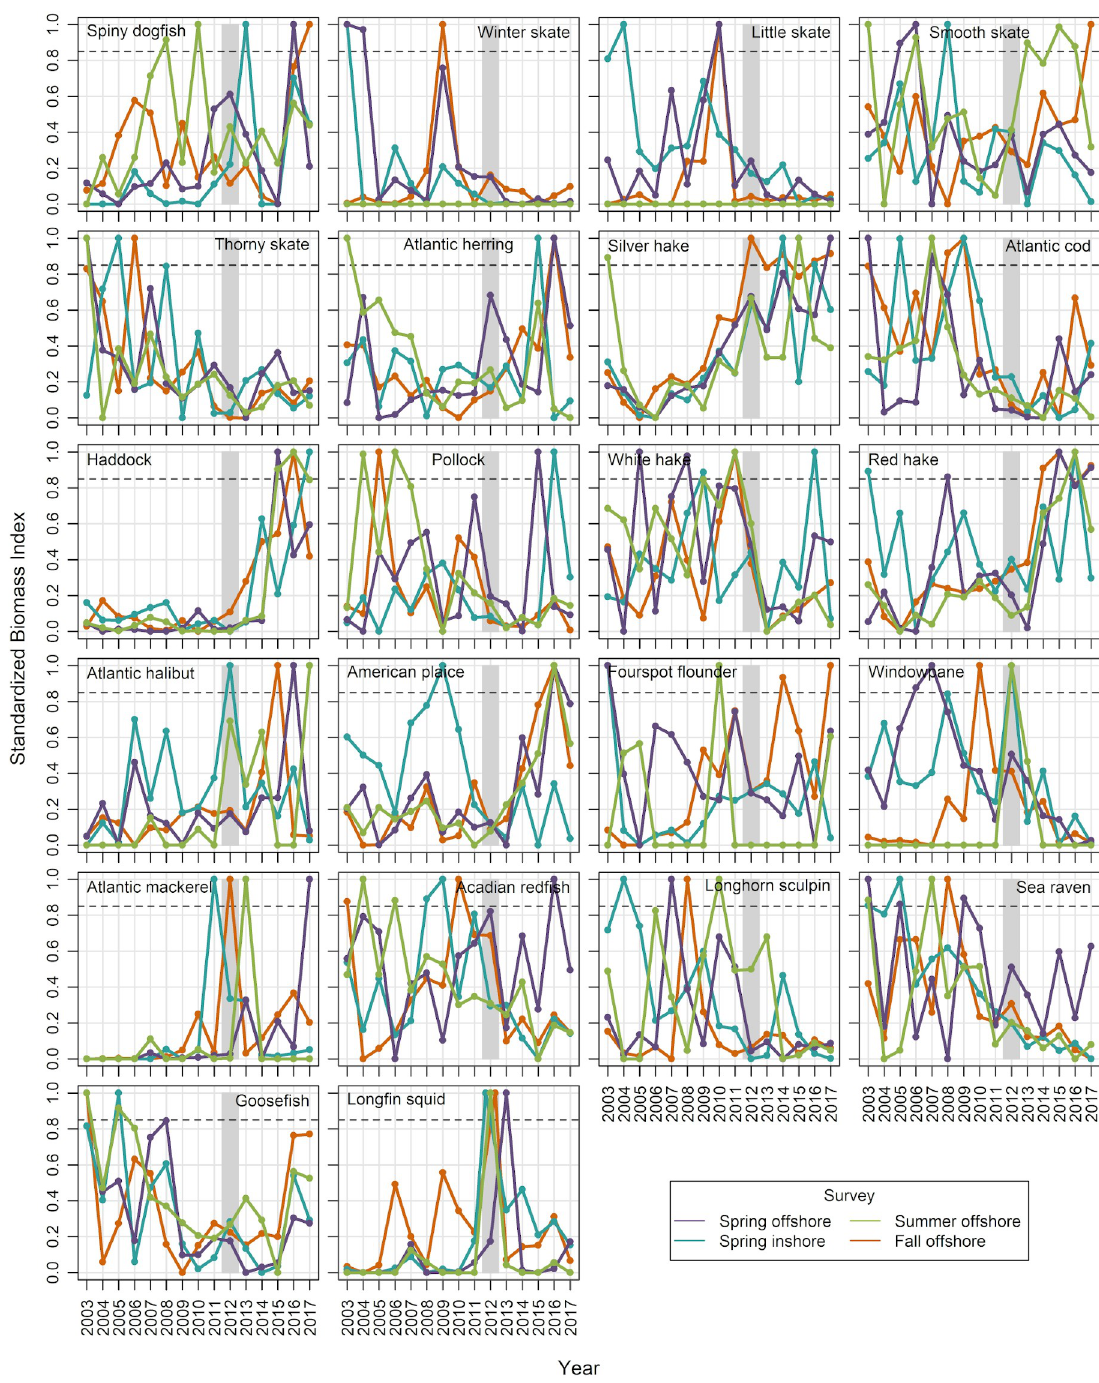
Fig 7. Standardized relative biomass indices (mean kg/tow) for northern shrimp predators in the western Gulf of Maine. Indices from offshore spring and fall surveys were calibrated for changes in survey methods beginning in 2009. Shaded bar highlights 2012, when the shrimp decline became apparent. Dashed line indicates standardized biomass = 0.85. Species were selected for further consideration if they had a standardized biomass index above 0.85 in 2012.